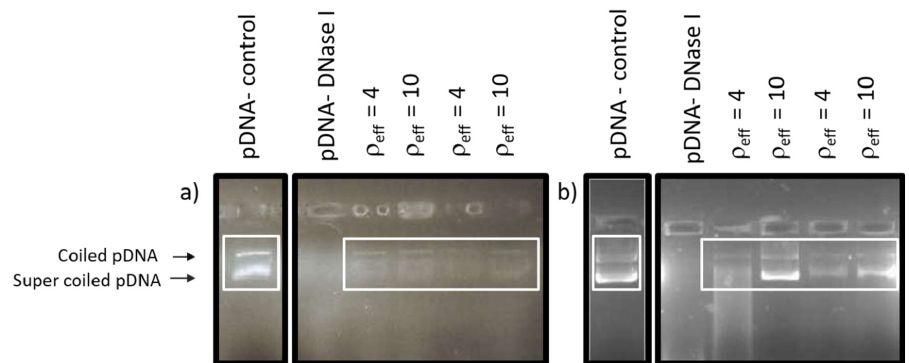
Figure 4. pDNA protection assay against degradation by DNase I (gel electrophoresis experiments):